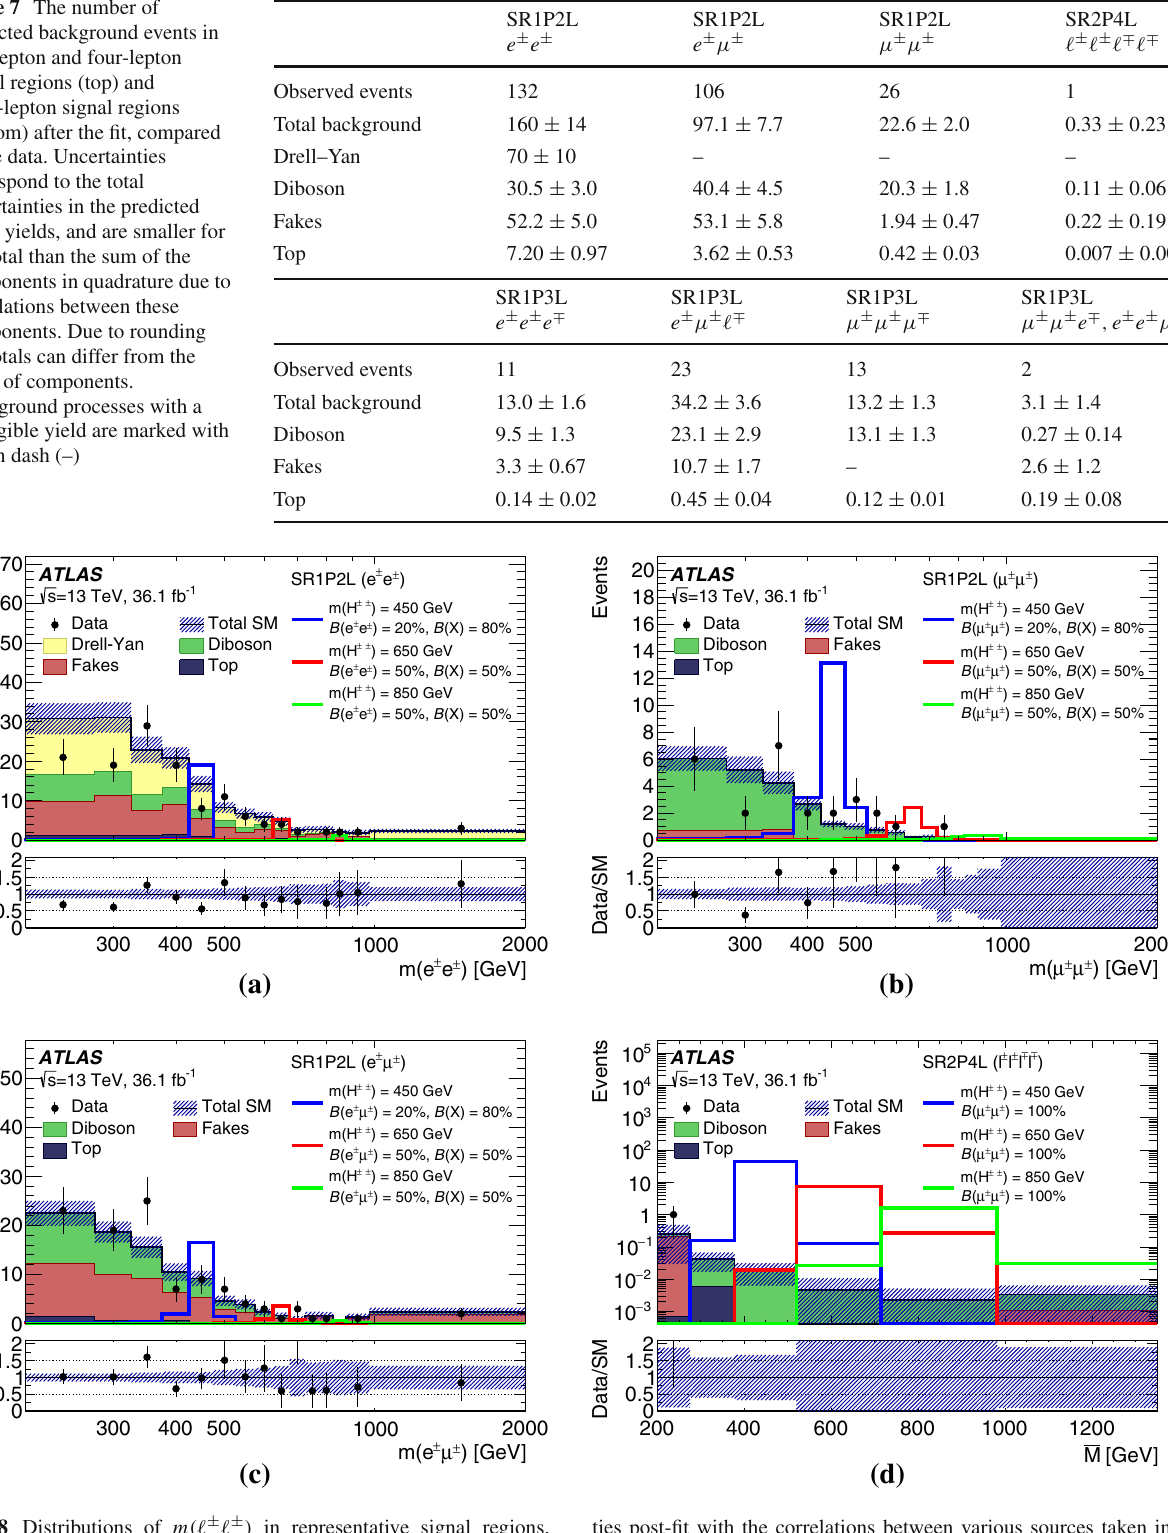
ties post-fit with the correlations between various sources taken into account. The solid coloured lines correspond to signal samples, nor- malised using the theory cross-section, with the H ±± mass and decay modes marked in the